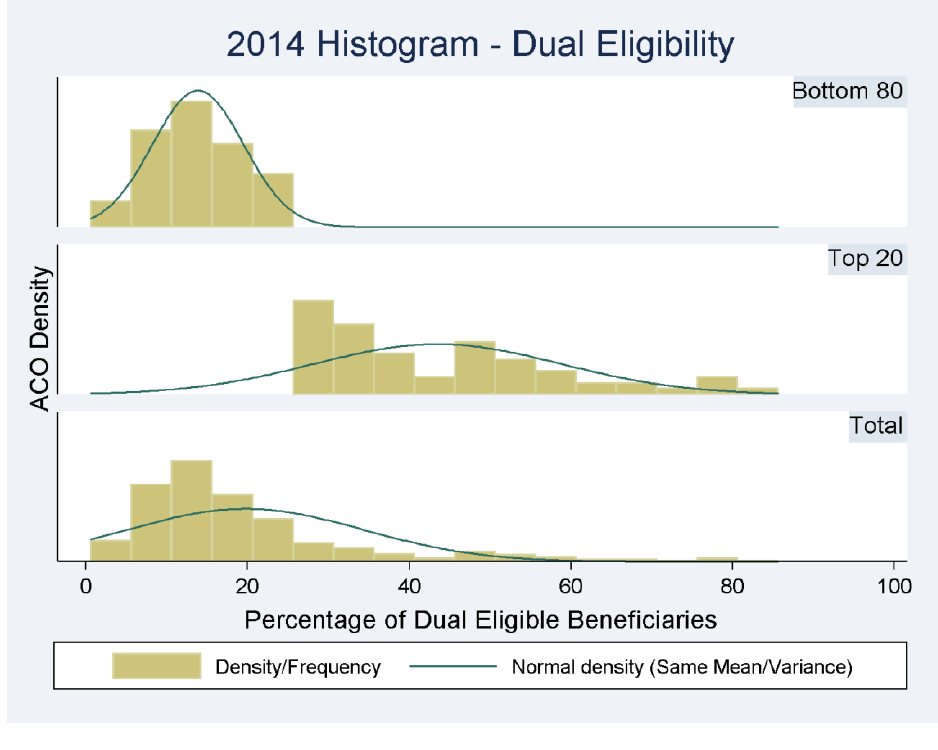
Figure 9.2: Distribution of Dually-enrolled Eligible Beneficiaries across ACOs